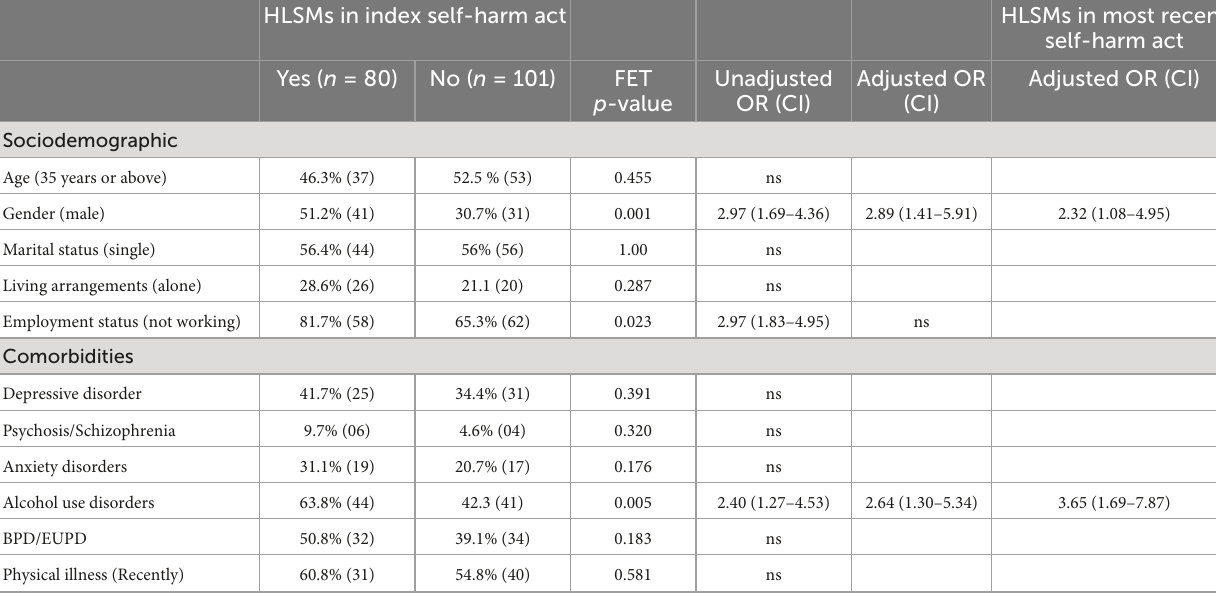
TABLE 4 Association of sociodemographic and comorbidity variables with the use of highly lethal self-harm methods in the index self-harm act and in the most recent self-harm act. HLSMs in index self-harm act HLSMs in most recent